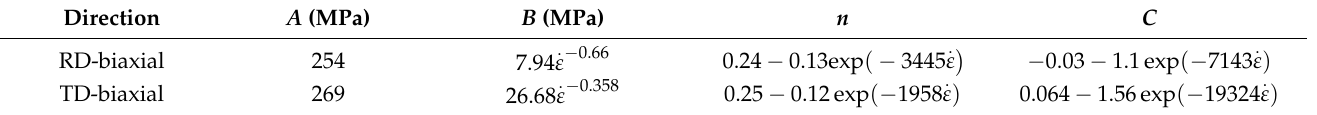
Table 5. Traditional JC model parameters for biaxially tensile